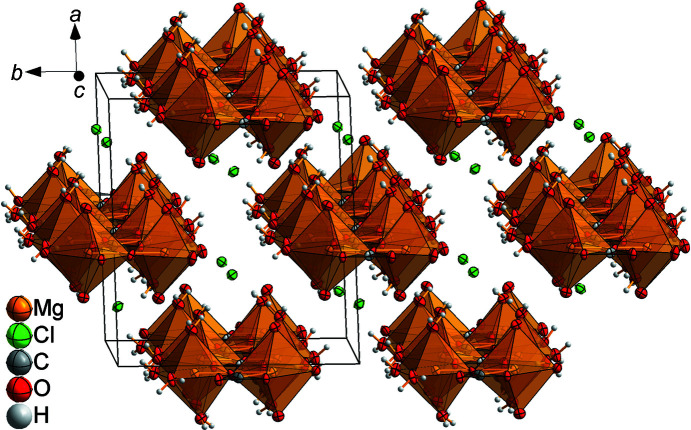
Excerpt of the crystal structure of MgCO3·MgCl2·7H2O, showing the zigzag-like stacking order of the double chains and the chloride ions between them.